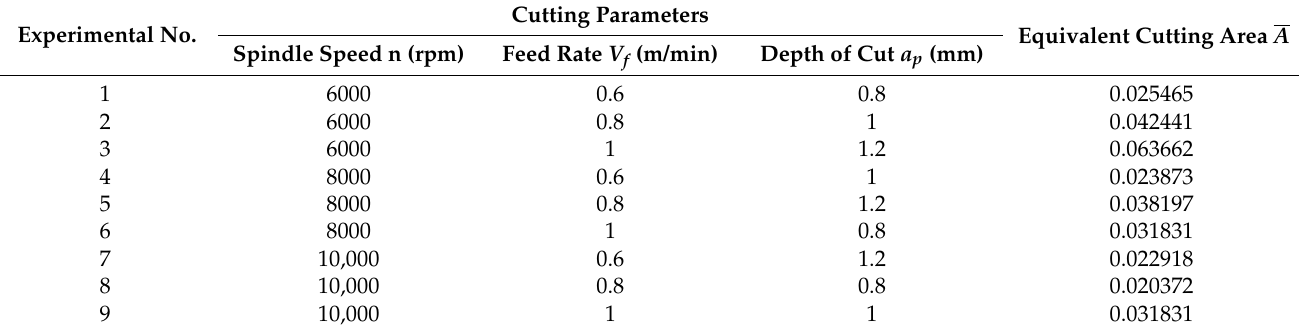
Table 3. Taguchi’s experimental design, L9 orthogonal array with levels of selected parameters.